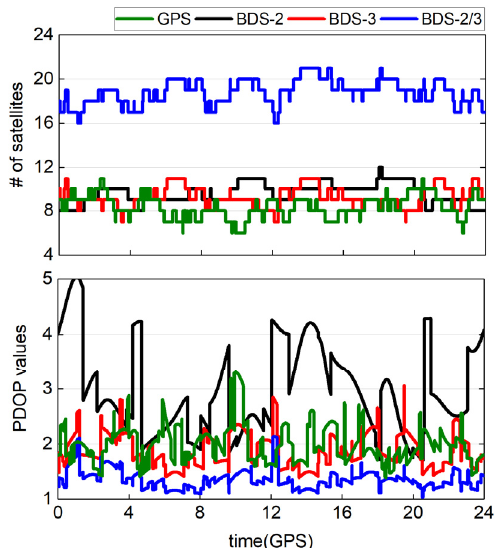
Table 6. The fixed rate of baseline and positioning RMS of fixed solution from different schemes for Station SC17.